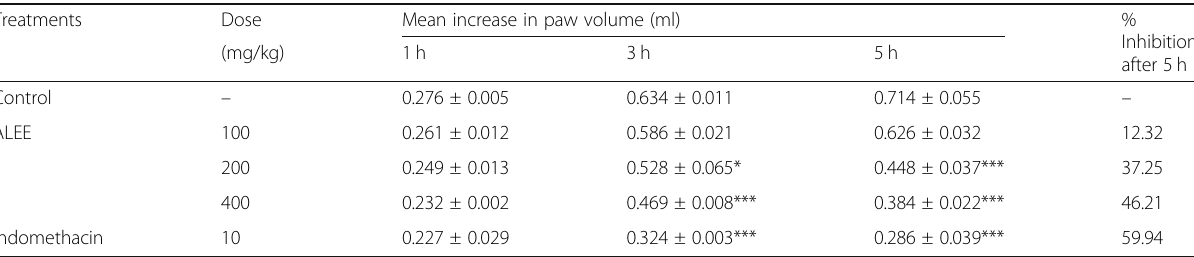
Table 4 Anti-inflammatory effect of ALEE on formalin-induced rat paw oedema